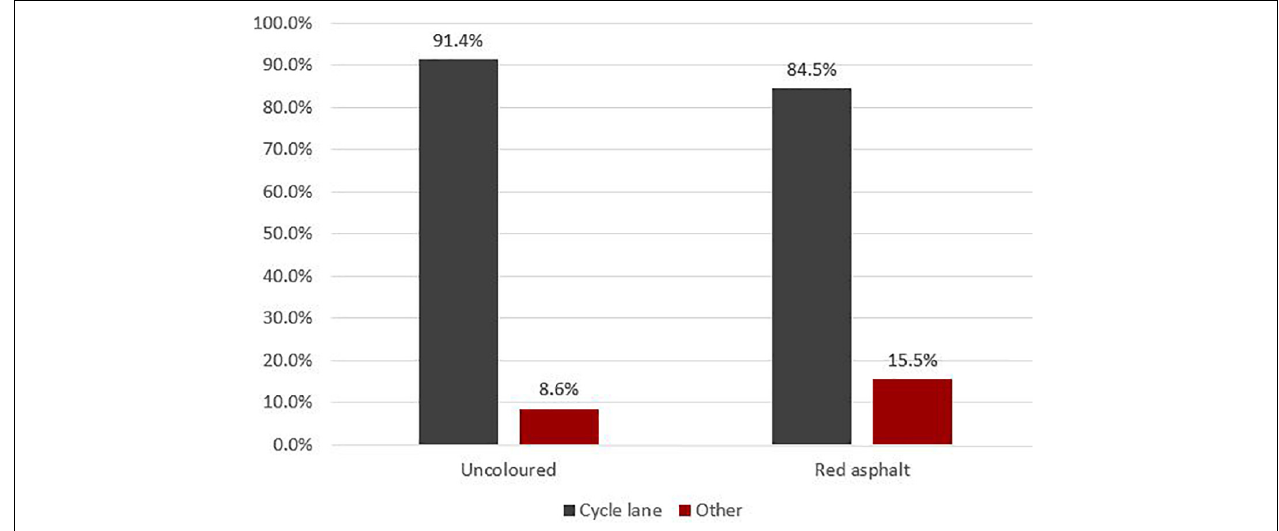
FIGURE 4 | Distribution of cyclist placement before and after recoating with red asphalt, N = 559.